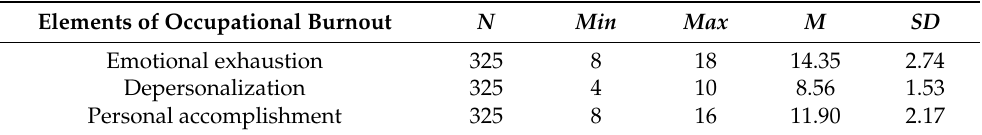
Table 2. Mean values of the occupational burnout level for the group under study according to the MBI questionnaire.